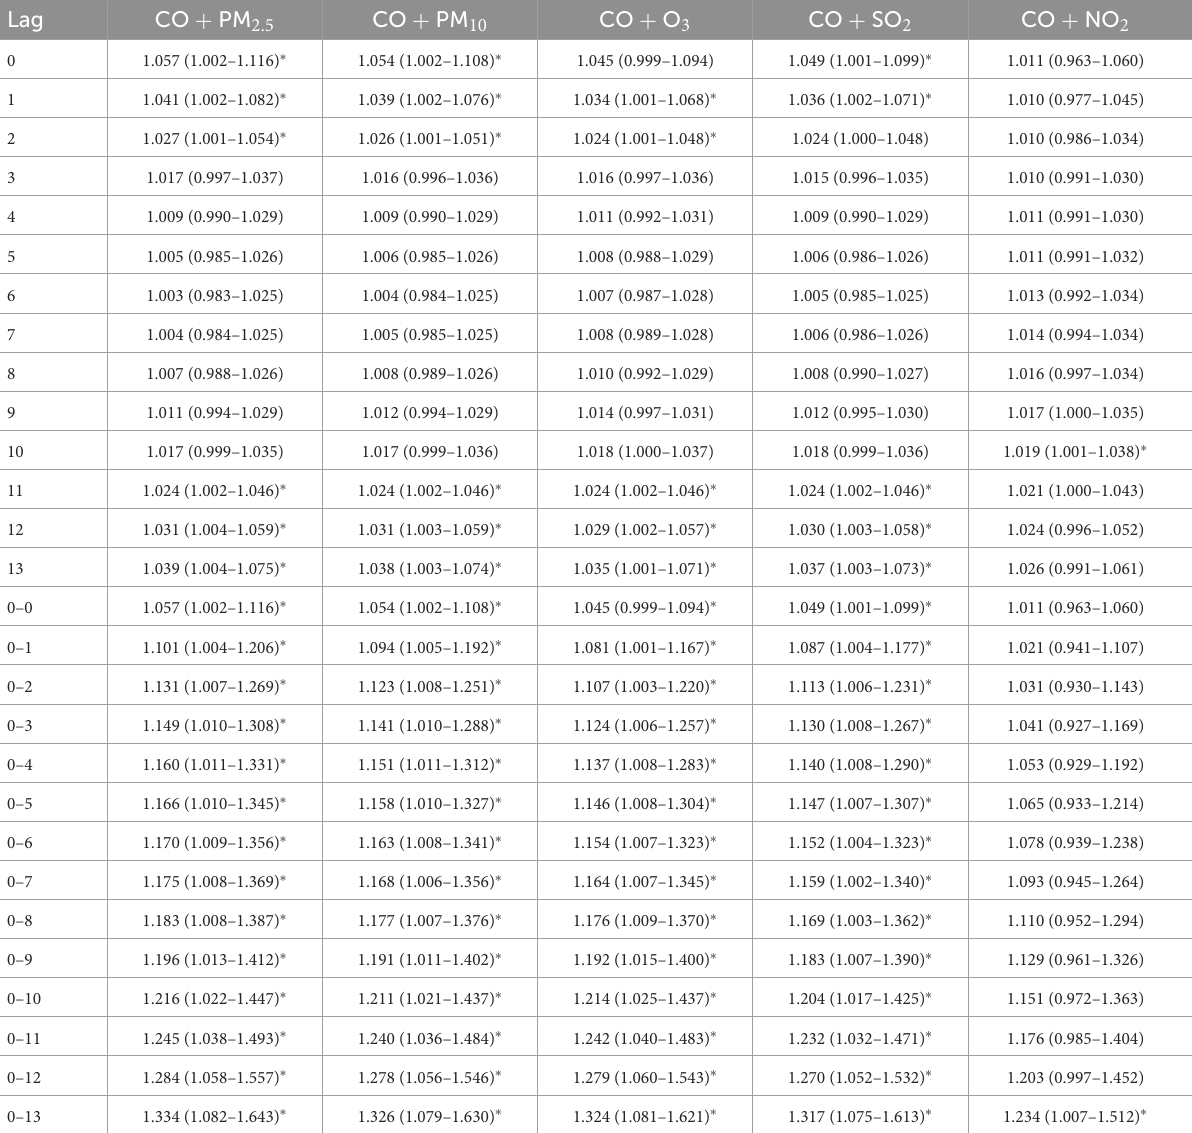
TABLE 3 The association between an increase of 1ug/m3 of CO and CHD admission in Hefei, 2014–2021 (dual pollutant model).